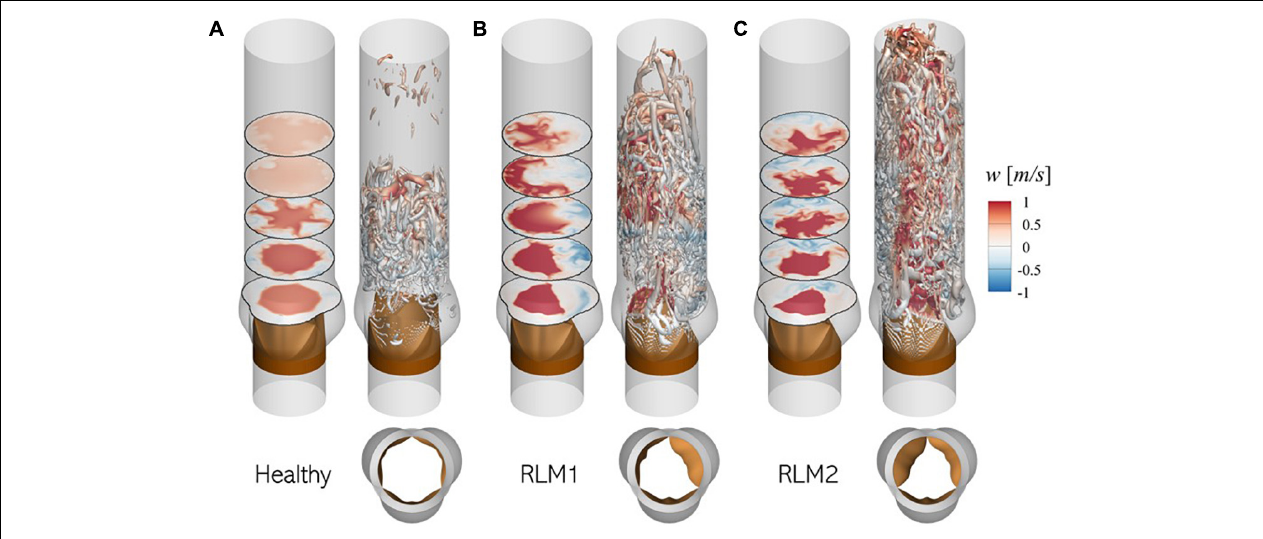
FIGURE 7 | Illustration of flow physics and aortic jet dynamics in (A) Healthy, (B) RLM1, and (C) RLM2 cases. In each case, the left panel shows contours of axial velocity in five axial planes: 1.5, 3.0, 4.5, 6.0, and 7.5 cm from the aortic annulus and the right panel shows iso-surfaces of Q-criterion (Q = 10 4 m/s 2 ) colored by axial velocity. Red colors indicate antegrade flow and blue colors indicate retrograde flow. Large regions of forward flow in a section plane can be used to identify aortic jet shape in that